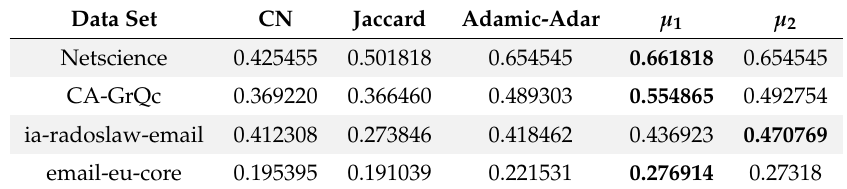
Table 3. Precision of best individual, RAND/1/EXP strategy. Best performance in bold.